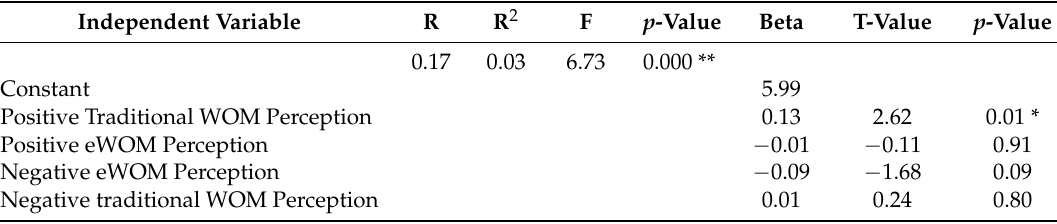
Table 6. The effects of Positive and Negative WOM on Destination